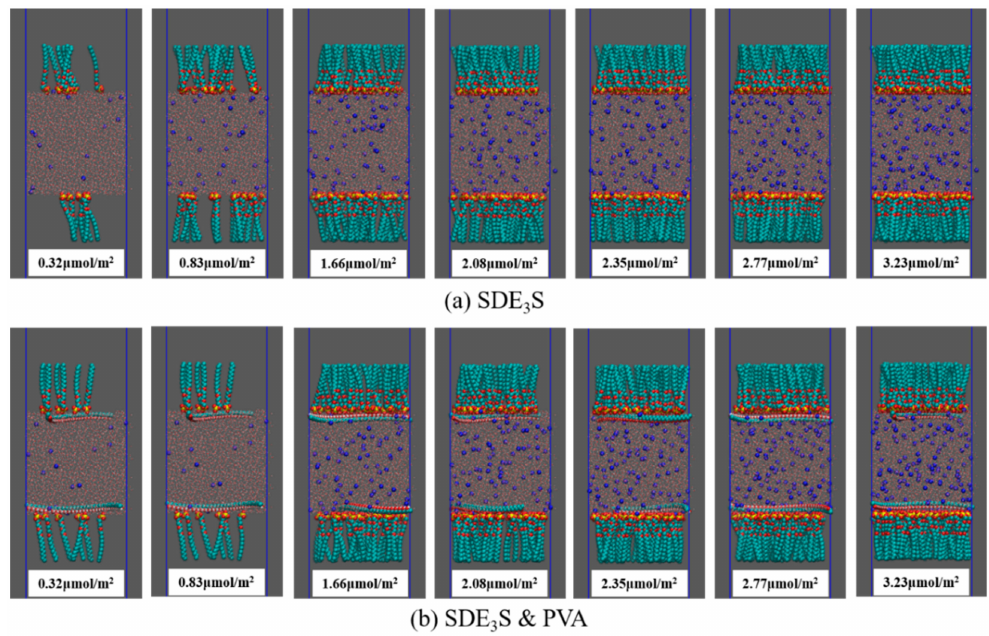
Figure 4. Initial configurations at the beginning of the simulations: ( a ) SDE 3 S systems; ( b ) SDE 3 S / PVA